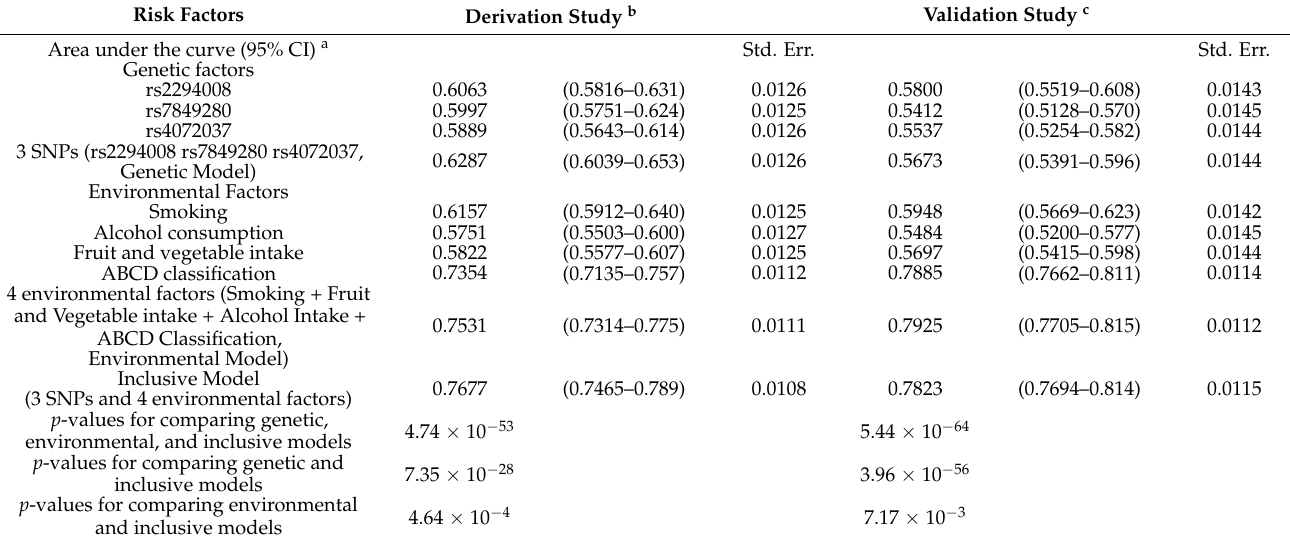
Table 4. Assessment of performance of the prediction model.